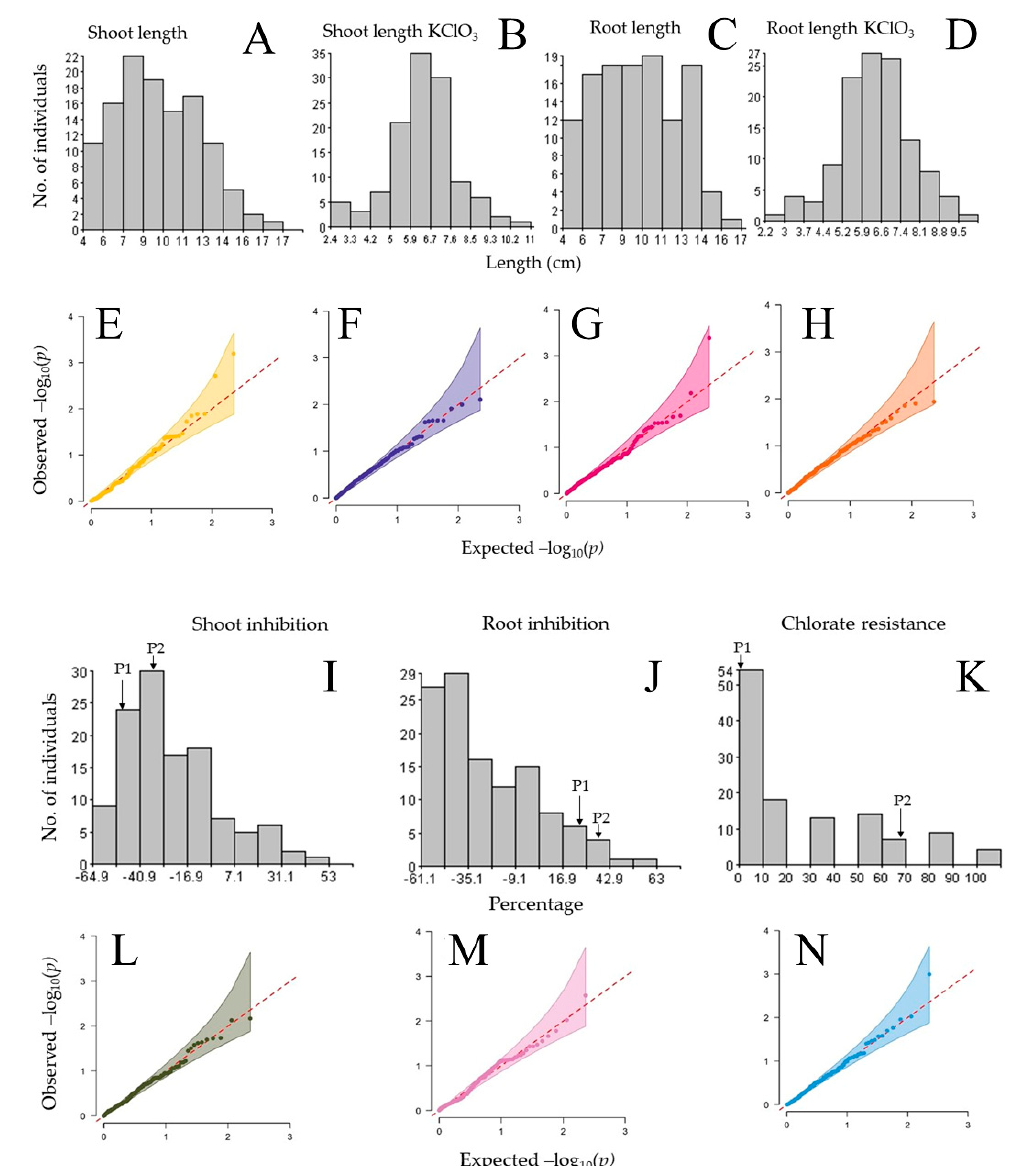
Figure 1. Trait frequency distributions under potassium chlorate treatment. ( A ) Frequency distribution of shoot length of 117 rice doubled haploid lines under normal growth conditions; ( B ) shoot length in response to 0.1% potassium chlorate (KClO 3 ) treatment; ( C ) frequency distribution of root length; ( D ) frequency distribution of chlorate resistance trait; ( E – H ) Quantile–Quantile (Q–Q) plots for shoot length under normal growth conditions and potassium chlorate treatment, shoot inhibition and root inhibition percentages, and chlorate resistance scores; ( I – K ) frequency distribution of shoot and root inhibition percentages, and chlorate resistance scores. ( L – N ) Q–Q plots related to shoot and root inhibition, and chlorate resistance. The red dotted lines in the Q–Q plots indicate the expected distribution under null hypothesis and the thick lines indicate the distribution from the observed associated traits. The frequency distribution and Q–Q plots were generated using hist function and ggplotr R package. P1 refers to 93-11 (parental line 1), and P2 indicates Milyang352 (parental rice line 2). − log10( p ) is the log base 10 quantile-quantile (Q-Q) of the p -values (observed and expected) for traits.